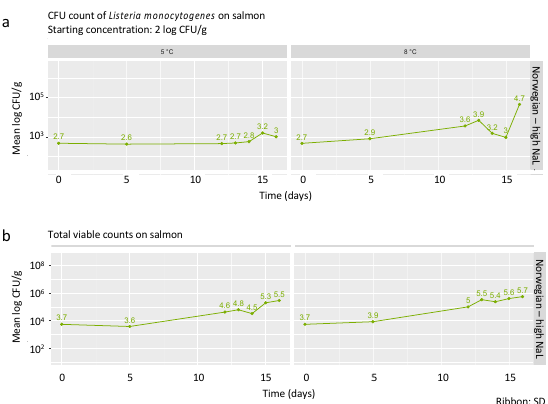
Figure 3. Growth curves of L. monocytogenes ( a ) and TVC ( b ) on Norwegian smoked salmon injected with 30% NaL. The numbers above the time points reflect the mean log CFU / g from three replicates. The shaded area around the line represents the standard deviation. Table 5. Growth potential δ of L. monocytogenes in Norwegian smoked salmon injected with 30% NaL, according to Commission Regulation (EC) No 2073/2005.